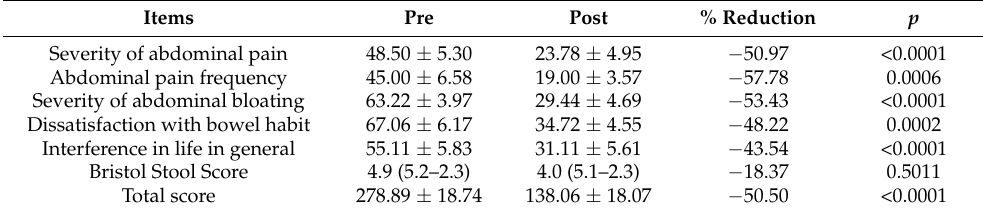
Table 1. Irritable bowel syndrome-symptom severity scale (IBS-SSS) single items, total score, and the Bristol stool score of IBS-D patients before (pre) and after (post) 12 weeks of a Tritordeum-based diet.